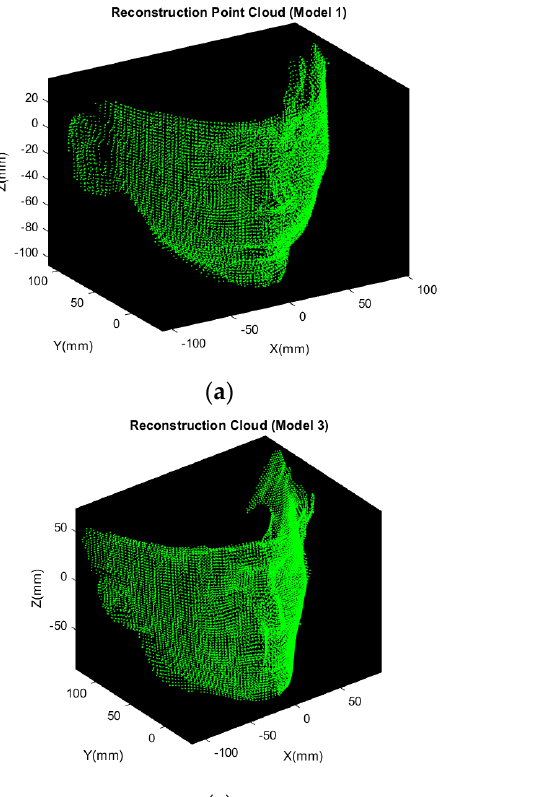
Table 1. Comparison between the original point cloud and reconstruction